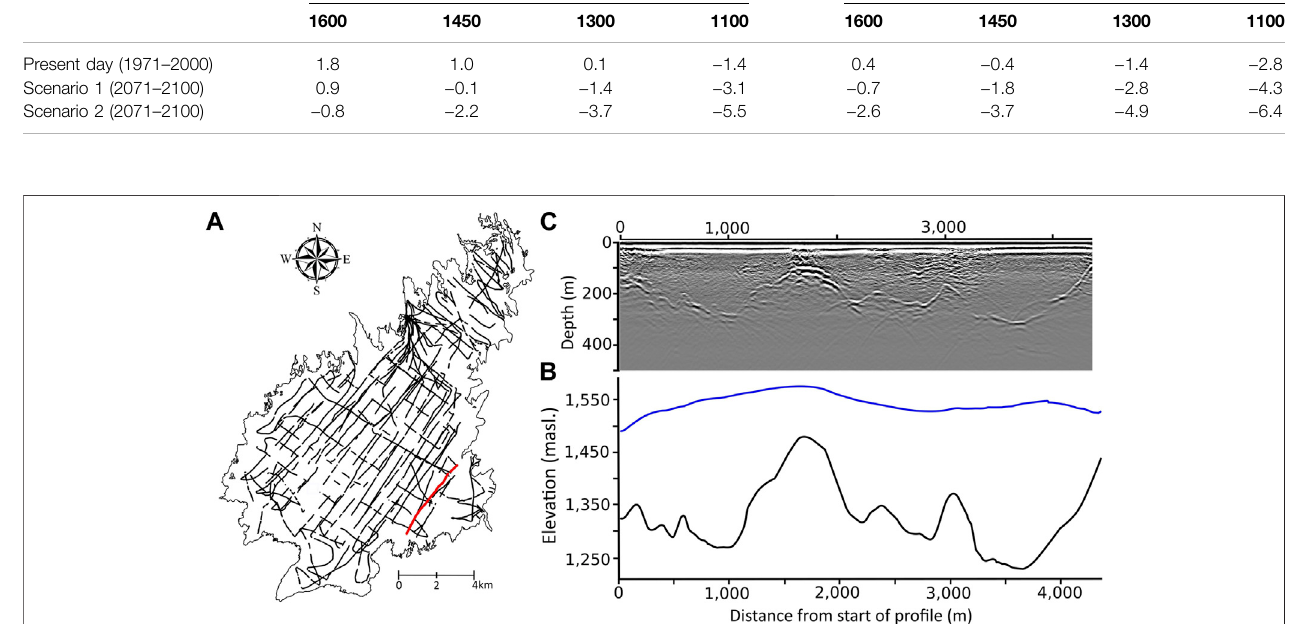
FIGURE 5 | (A) Ice thickness pro fi les used for the interpolation of ice thickness and subglacial bed topography. (B) One radar pro fi le displayed as a graph of the interpretedsubglacialbedtopography(blackline)andglacialicesurface(blueline;masl.). (C) Theprocessedradarpro fi leusedfor (B) .Thepro fi lesinBandCaremarked as a red line in (A)